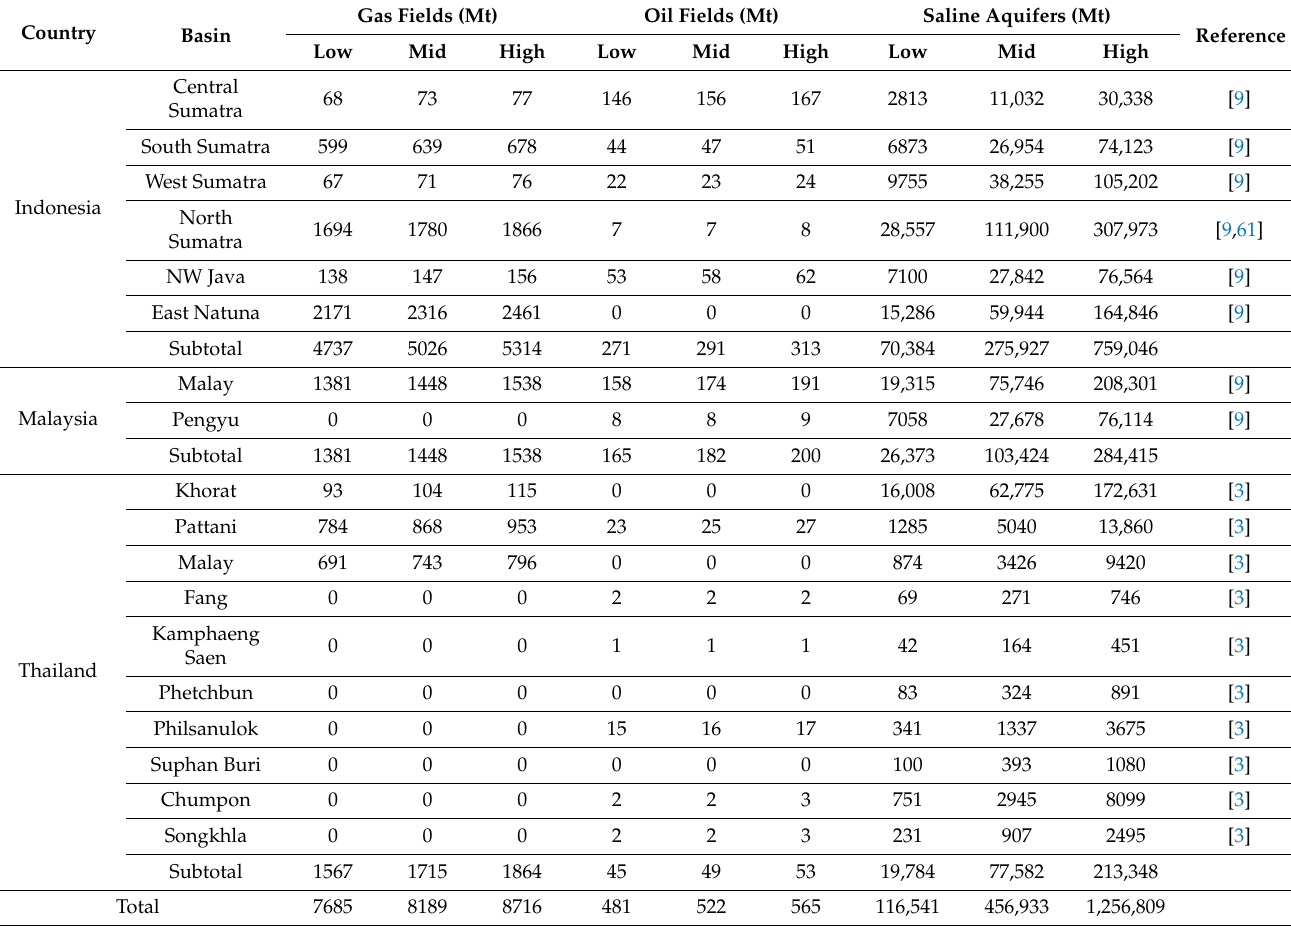
Table 4. CO 2 storage capacity in selected sedimentary basins in